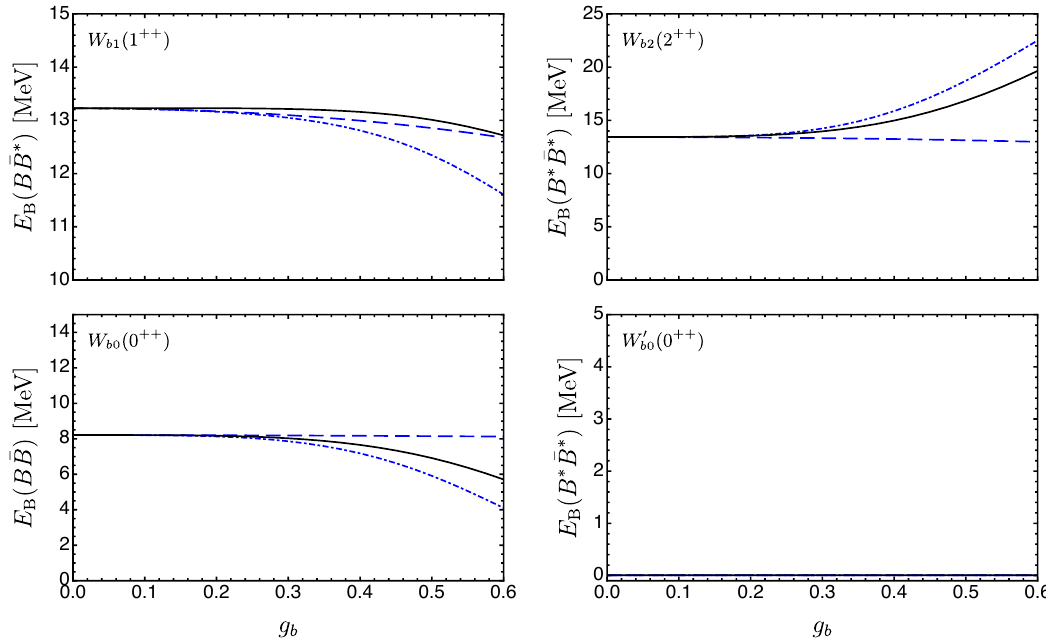
Figure 2 . The binding energies of the Z b ’s spin partners as functions of the coupling constant g b for the physical mass splitting (cid:14) between B (cid:3) and B mesons. The binding energies of the Z b and Z 0 states are used as input | see eq. (4.1). The notation of curves is the same as in (cid:12)gure 1. The b results are obtained with the sharp cuto(cid:11) (cid:3) = 1 GeV in the integral equations (3.12).